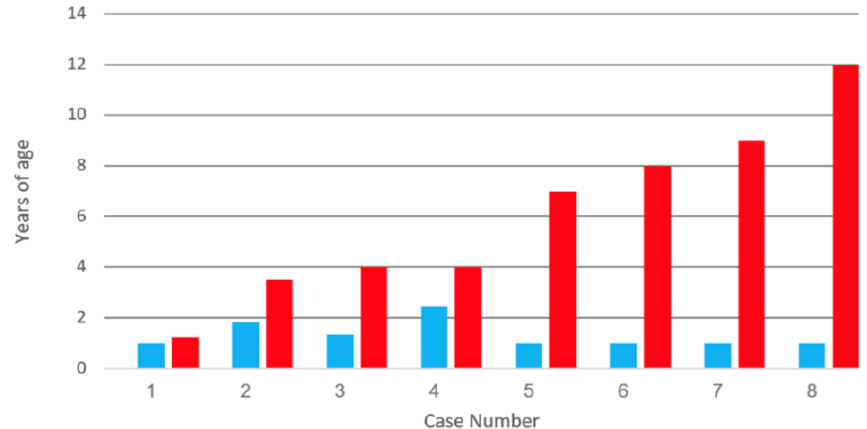
Figure 1. Duration between varicella vaccination and varicella vaccine meningitis in eight children. All children had received one varicella vaccination, after which they later developed herpes zoster and meningitis. Data from references [8,12,13]. Note the absence of pattern to the time intervals between vaccination and meningitis. Age of varicella vaccination: blue bar; age of meningitis: red bar.